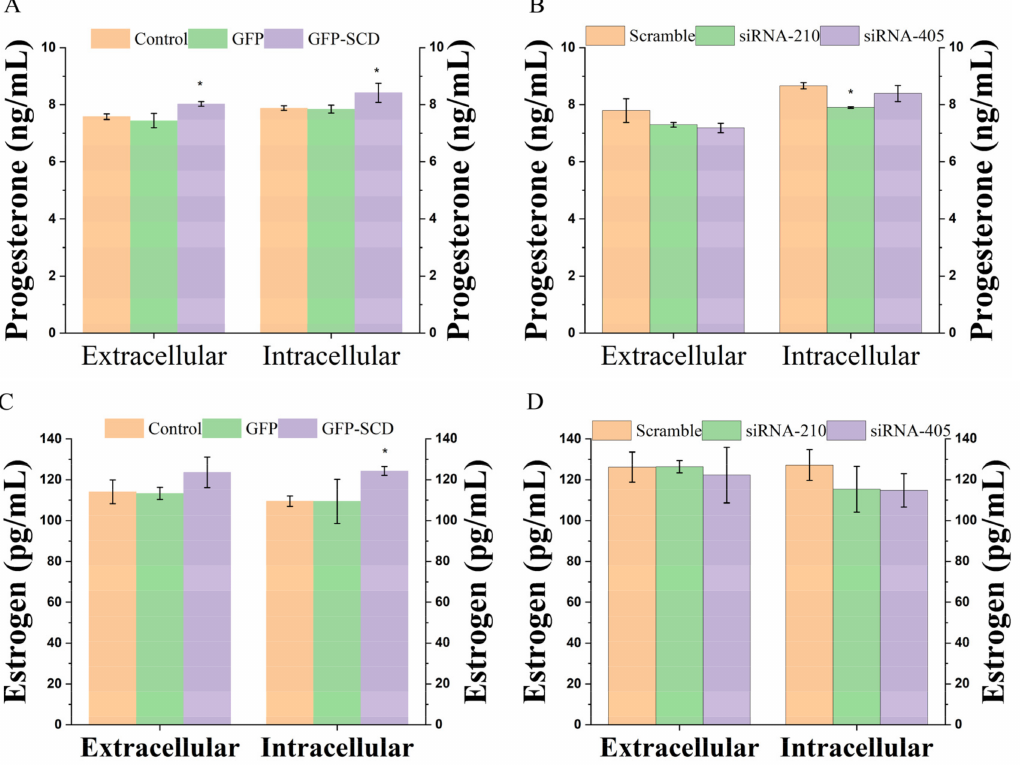
Figure 3. Changes in intracellular and extracellular progesterone and estrogen levels after transfection. ( A , B ) Change in progesterone (Unit: ng/L). ( C , D ) Change in estrogen (Unit: pg/L). Asterisks indicate a significant intracellular or extracellular difference between groups ( p <